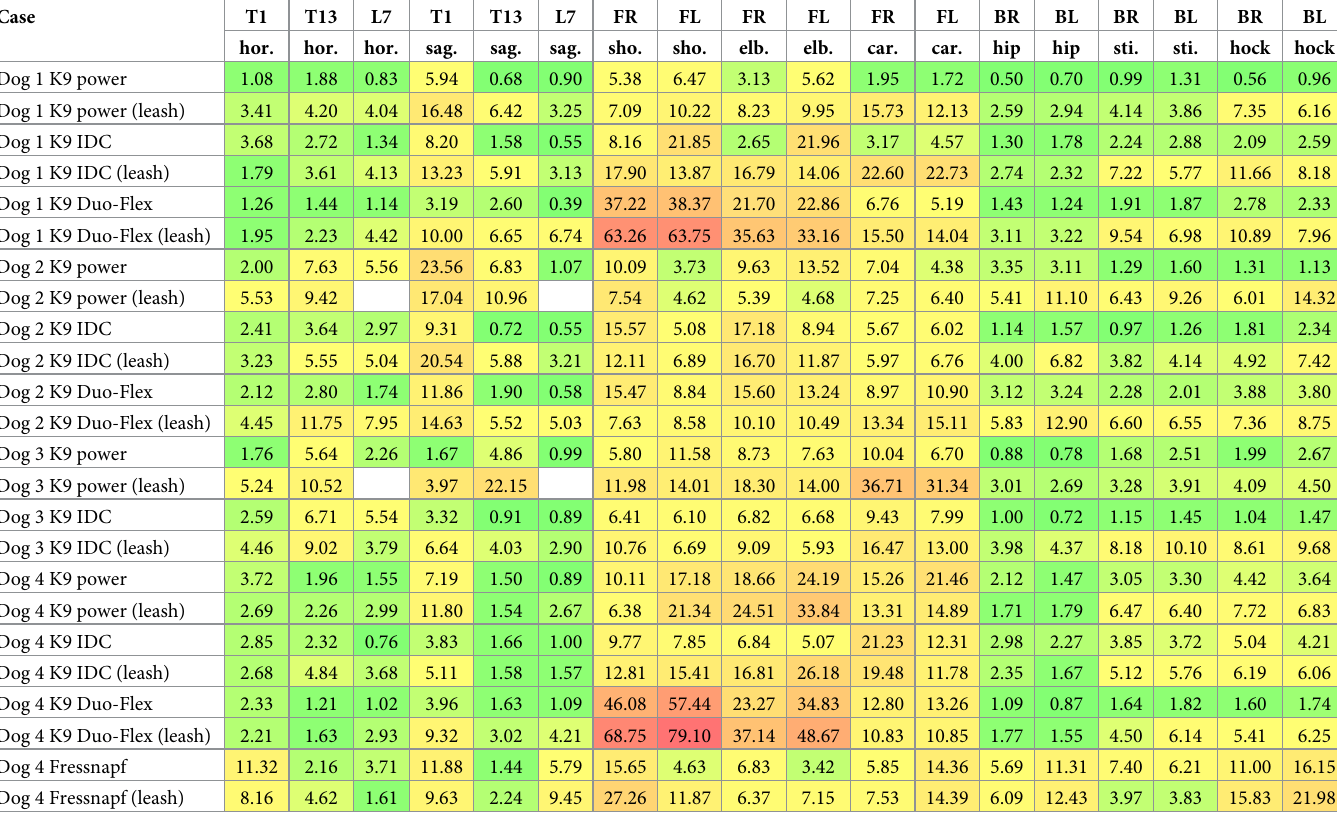
Table 4. RMS error values for average joint angle differences.